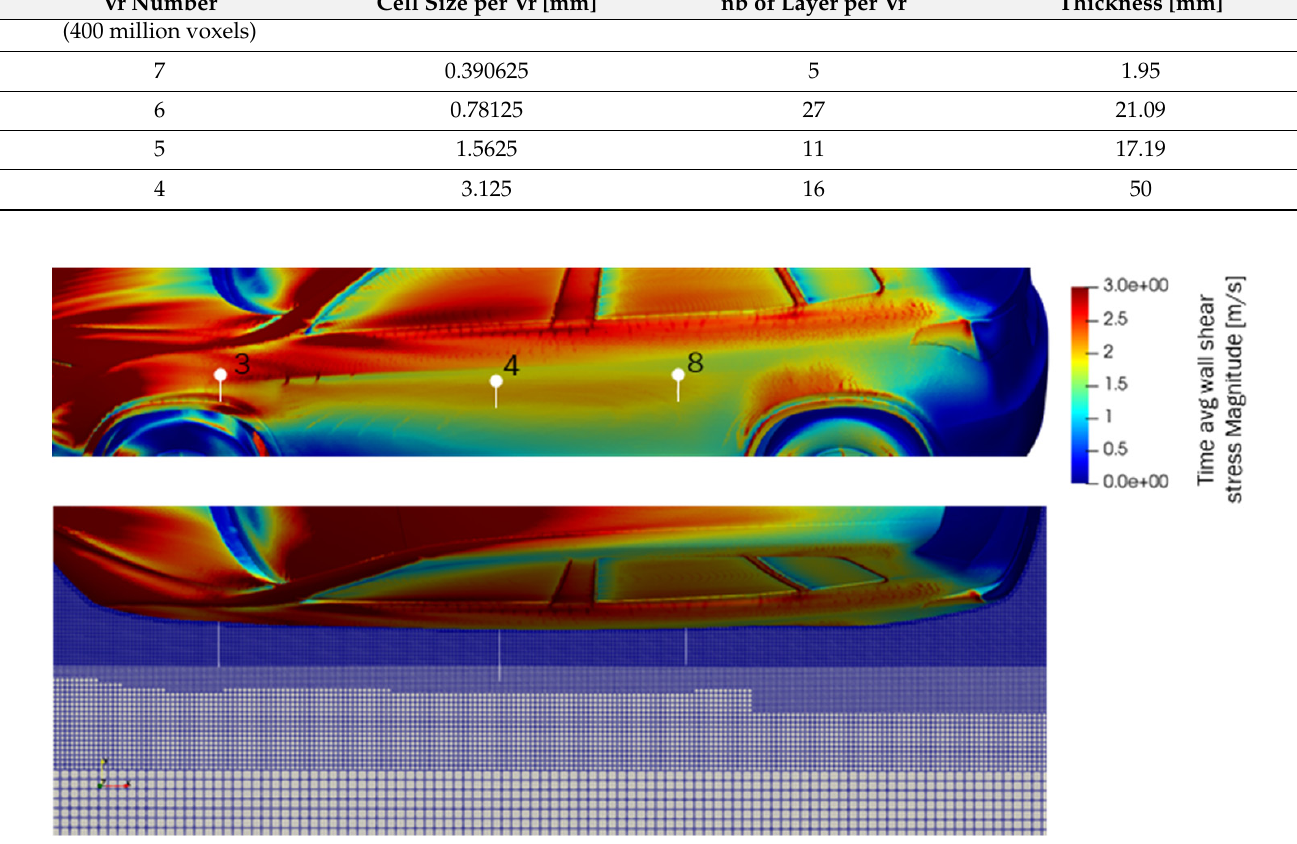
Figure 4. Wall shear stress computed with the most refined grille at Z = 140 mm ( bottom view ). The